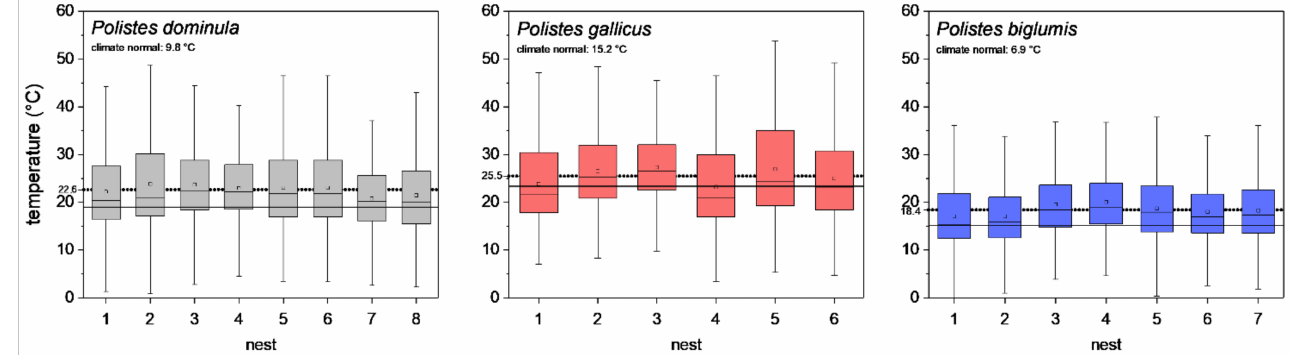
Figure 2. Ambient air temperatures at paper wasp nests during a breeding season (May–October 2018–2020). Box and whisker plots represent median temperatures with first and third quartiles, dots in plots are means. The dotted line indicates the mean of all nests, and the solid line shows the meteorological standard mean ambient temperature (May–October 2018–2020) of the nearest weather stations. The climate normal values (1981–2010) of the nearest weather stations ( P. dominula : Graz, P. gallicus : Firenze, and P. biglumis : Kornat) are indicated. All single nest temperatures of P. dominula , P. gallicus , and P. biglumis differed significantly from the meteorological standard ambient temperature of the nearest weather stations ( p < 0.05, pairwise Bonferroni